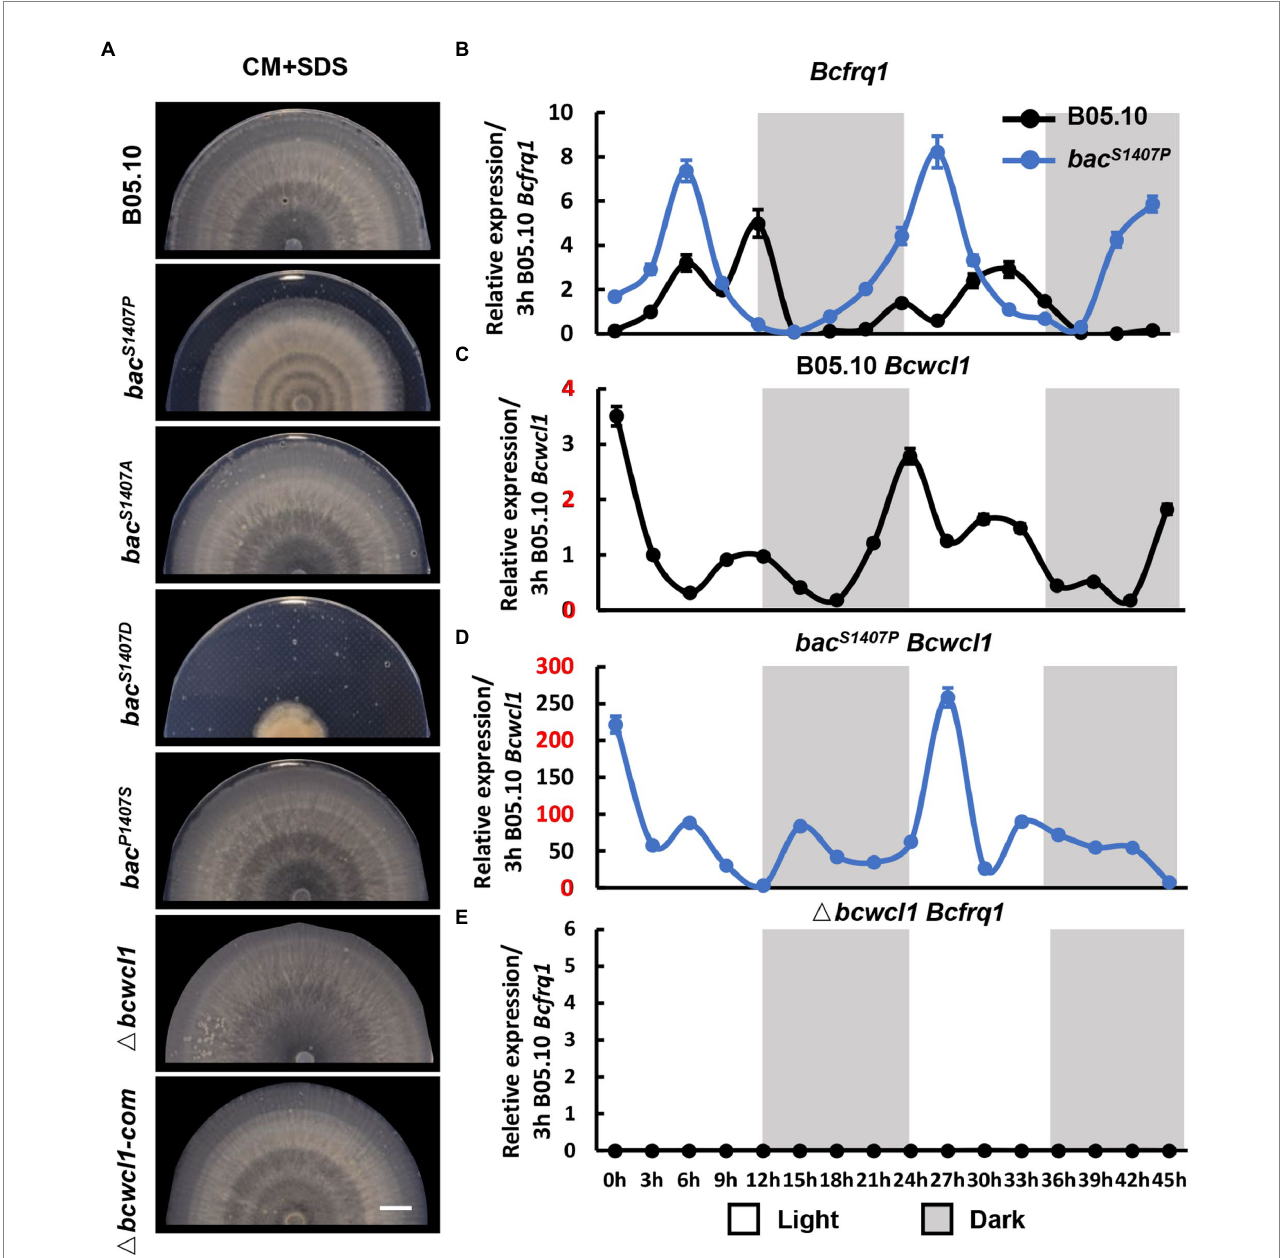
FIGURE 7 (A) The banding pattern of the mycelial colony produced by the wild type (B05.10) and mutant ( bac S1407P , bac S1407A , bac S1407D , bac P1407S , Δ bcwcl1 , and Δ bcwcl1-com ) strains on SDS-containing CM medium for 7 days under LD conditions. SDS-containing CM medium was used to reduce mycelial growth to approximately 50% of ordinary radial growth to obtain a clearer pattern. The white bar represents 10 mm. The expression of circadian clock components Bcfrq1 in wild-type B05.10, bac S1407P (B) and Δ bcwcl1 (E) , and Bcwcl1 in the wild type (C,D) . The expression of B05.10 Bcfrq1 at 3 h (B,E) and B05.10 Bcwcl1 at 3 h (C,D) was used as a ruler to compare the expression changes of genes at different time points under LD conditions for 2 days. Error bars are standard deviations ( n =